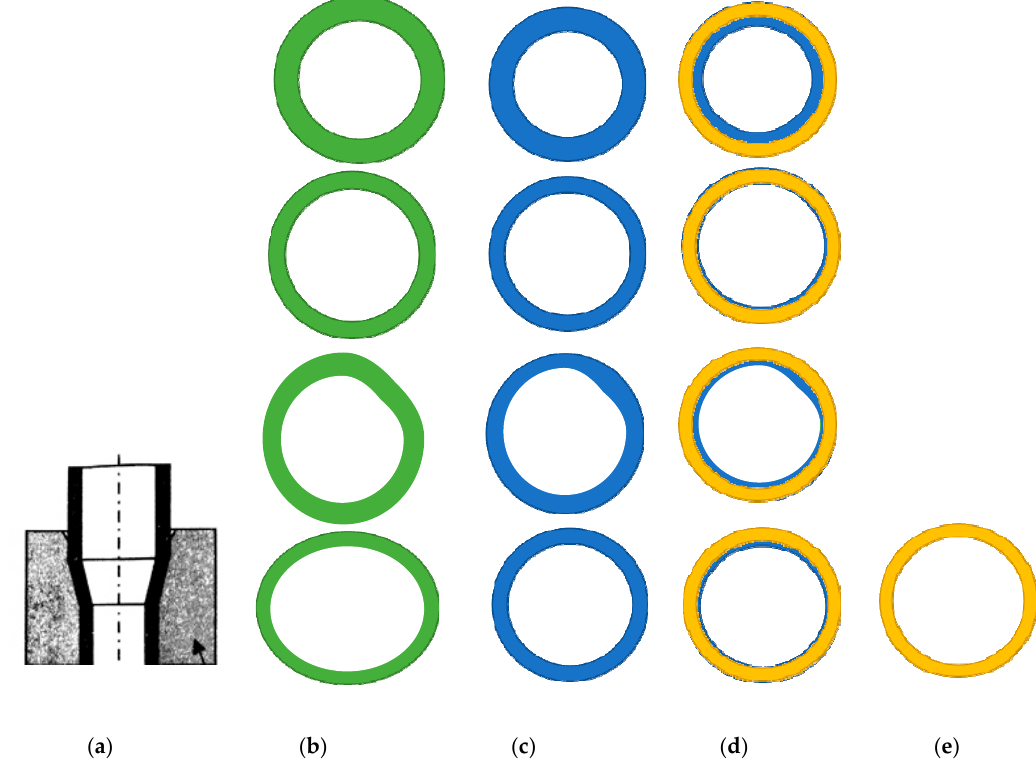
Figure 2. ( a ) Tube reducing. ( b ) Cross-section of original culms. ( c ) Outside reducing. ( d ) Inside milling. ( e ) Uniform circular end with constant thickness and diameter.